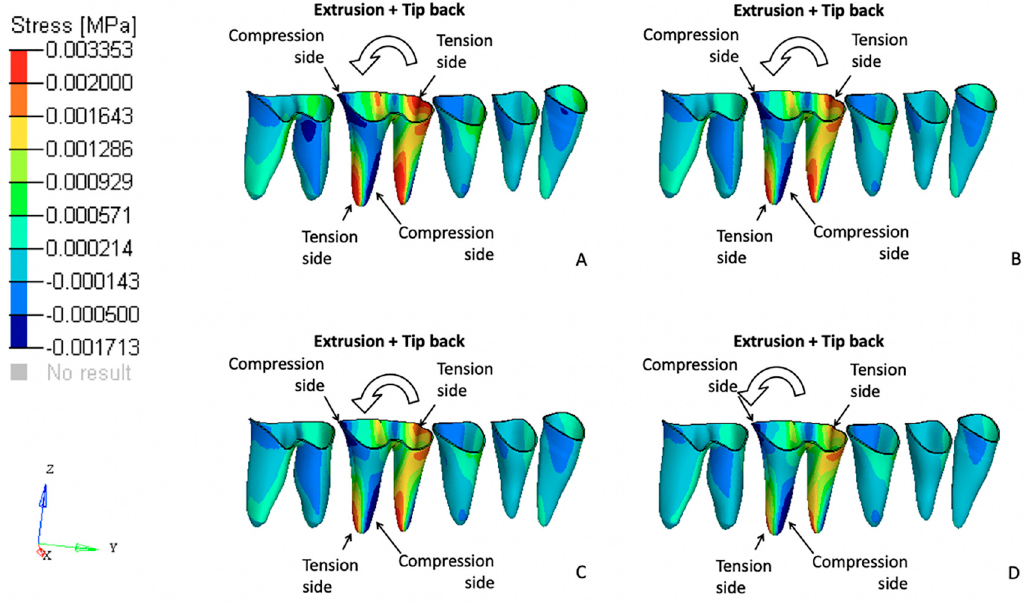
Figure 8. Von Mises stress on the teeth that served as the posterior anchorage unit from a sagittal view. ( A ) FEM 1, ( B ) FEM 2, ( C ) FEM 3, and ( D ) FEM 4. The greatest displacement values were registered in FEM 1 (2.067 × 10